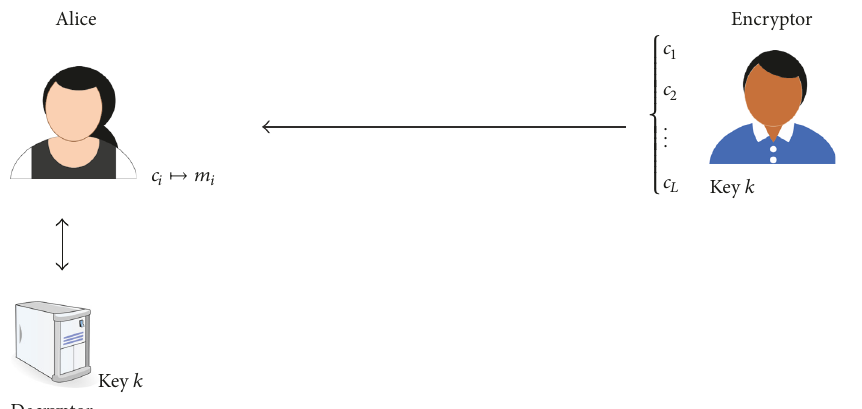
Figure 1: Blind decryption. Alice has obtained 𝐿 ciphertexts from an encryptor and is entitled to choose exactly one of those for decryption. Alice interacts with a decryptor that shares a key 𝑘 with the encryptor to transform the ciphertext message 𝑐 𝑖 into a plain-text message 𝑚 𝑖 . Neither the encryptor nor the decryptor learns the plain-text message chosen by